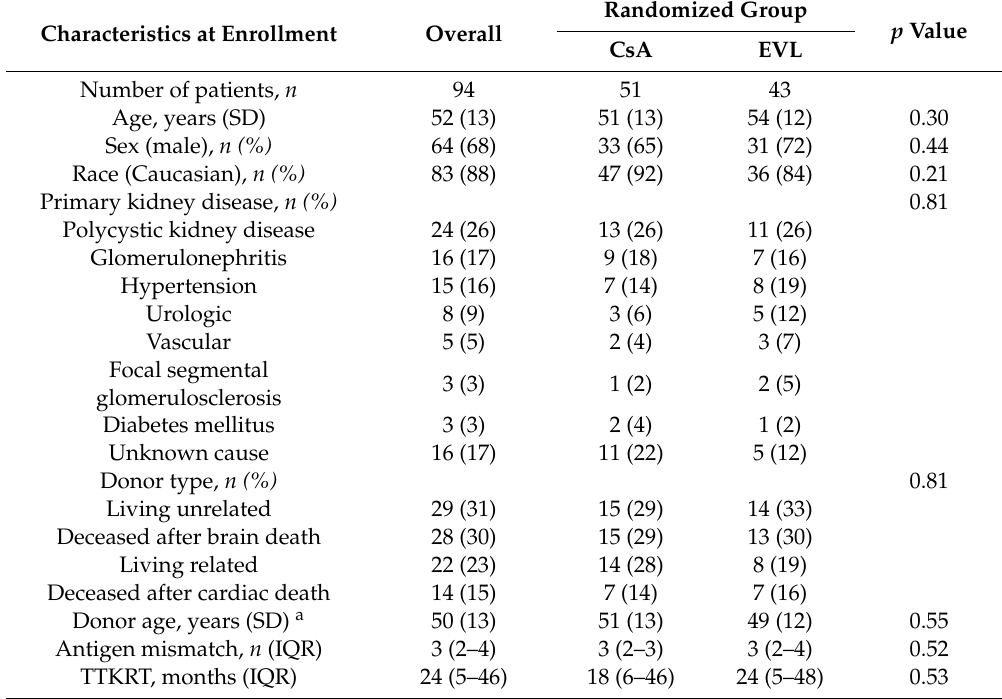
Table 1. Characteristics at enrollment of study population, overall kidney transplant recipients (KTRs), and randomization groups.